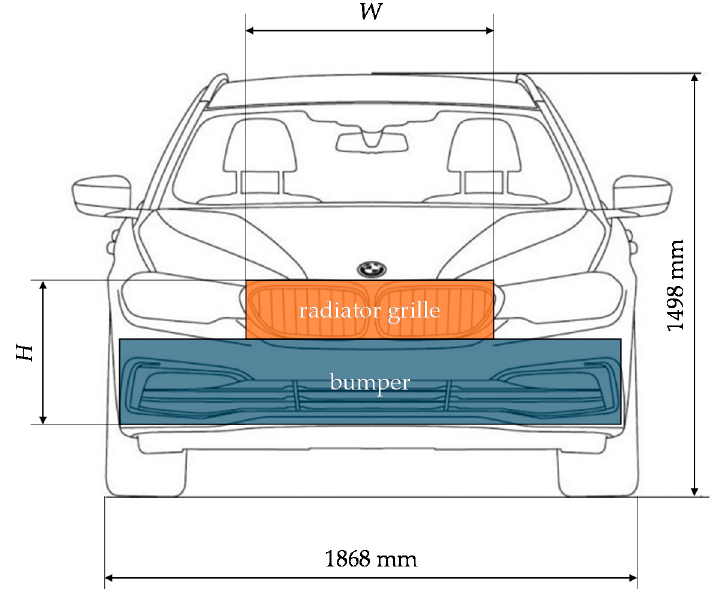
Figure 1. Dimensioning of the vehicle front using the technical drawing [17] of a BMW 5 Touring model as an example. We divided the front into separate radiator grille and bumper sections.